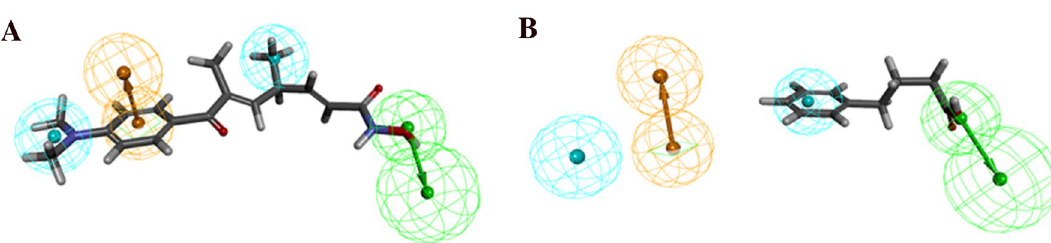
Figure 3. Alignment of Hypo 1 to training set compounds; ( A ) Most active compound 1 (IC 50 = 0.84 nmol/L) and ( B ) Least active compound 24 (IC 50 = 260,000 nmol/L). The most active compound mapped to all four features in Hypo 1, whereas the least active compound missed the RA and HYP features. The figure is drawn using DS